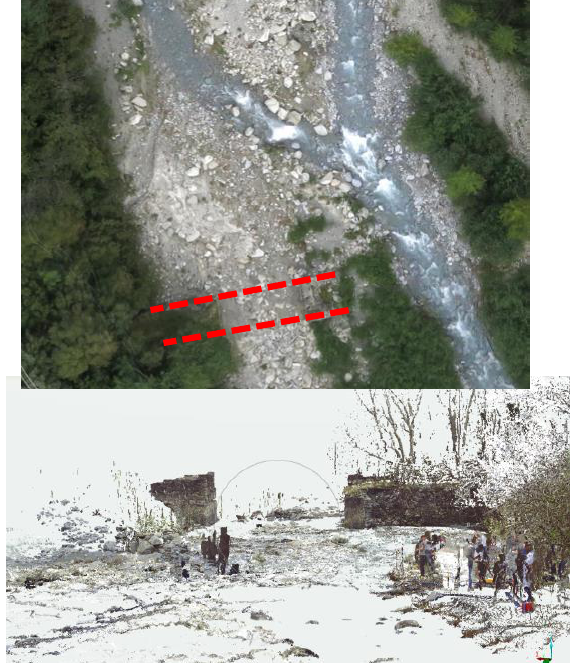
Figure 5. The ancient collapsed bridge, (above) an excerpt from the orthophoto and (below) a view of five scans registered cloud while the y profiles were 100, spaced 0.5 m and 20 m long. The trace duration was 150 ns with a sampling rate of about 6.8 GHz. On average, along x and y, the interval between the radar traces was 6 cm. After a standard processing (Sambuelli et al., 2014) the timeslices were extracted and the images on the x-y plane were placed after the GPS data collected during the acquisition.